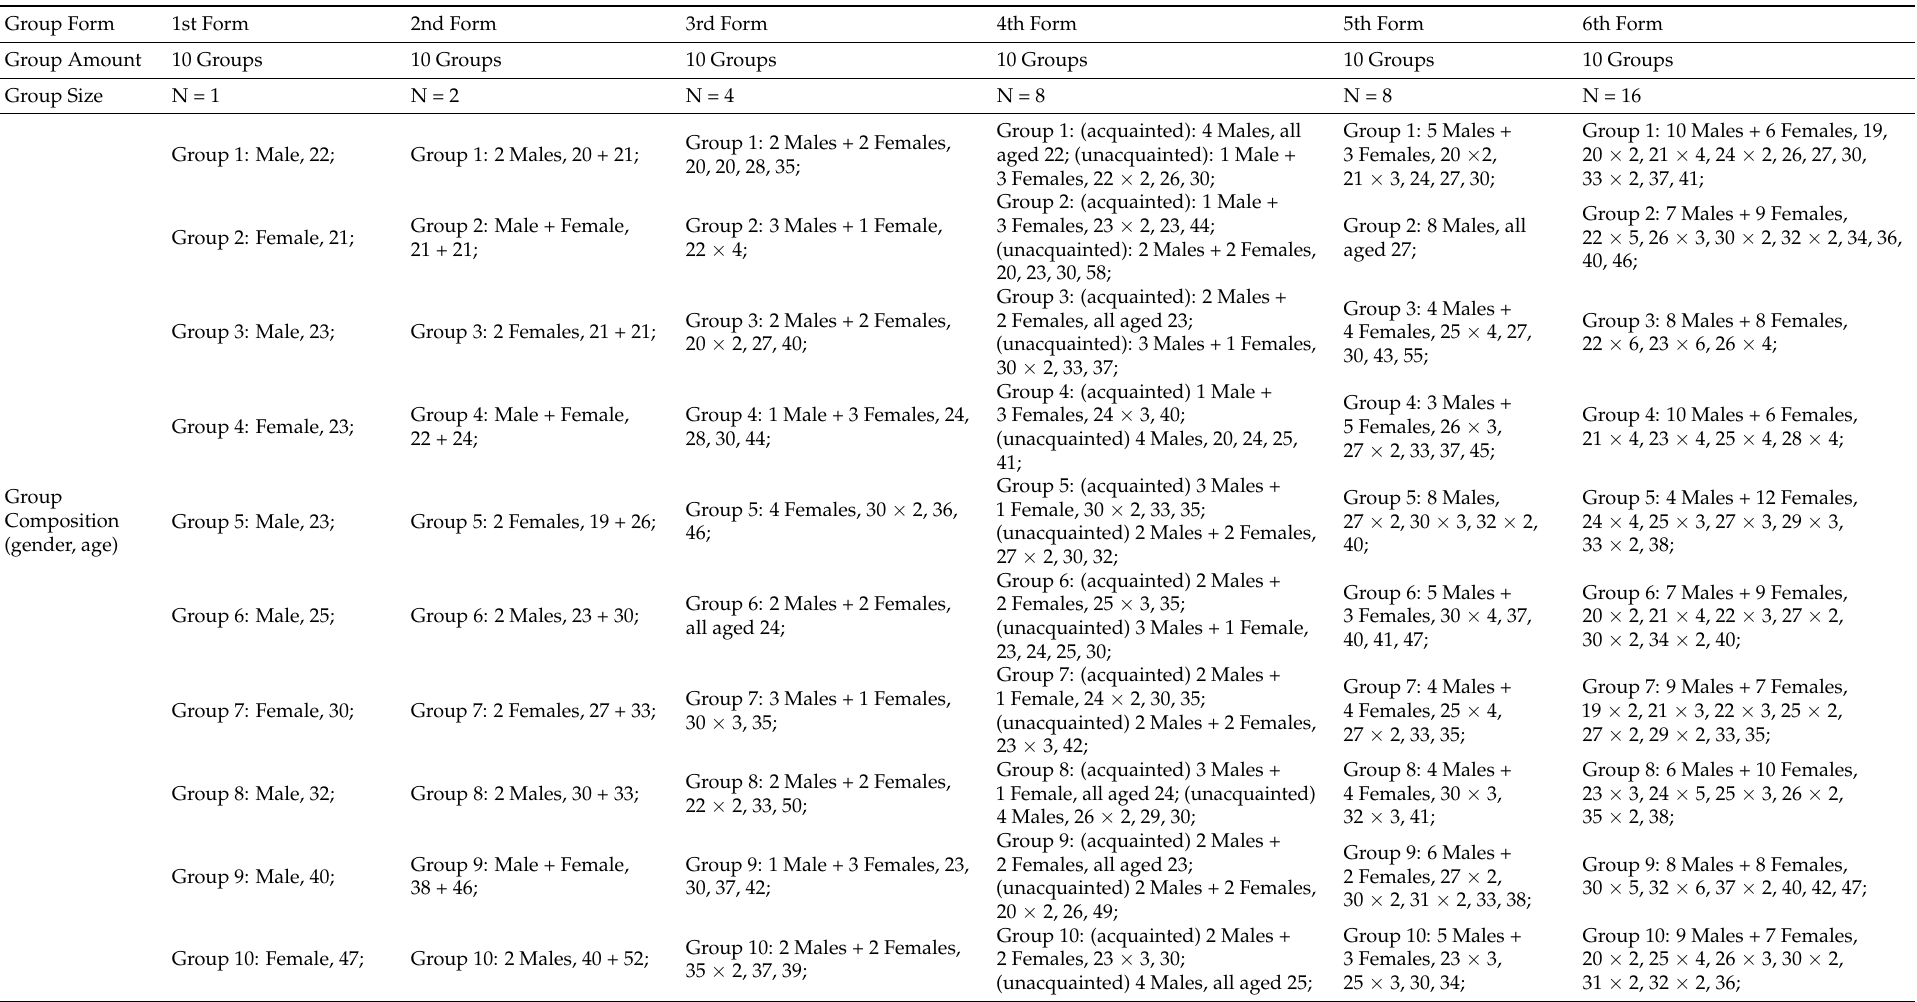
Table 1. Overall information about the composition of 60 experimental